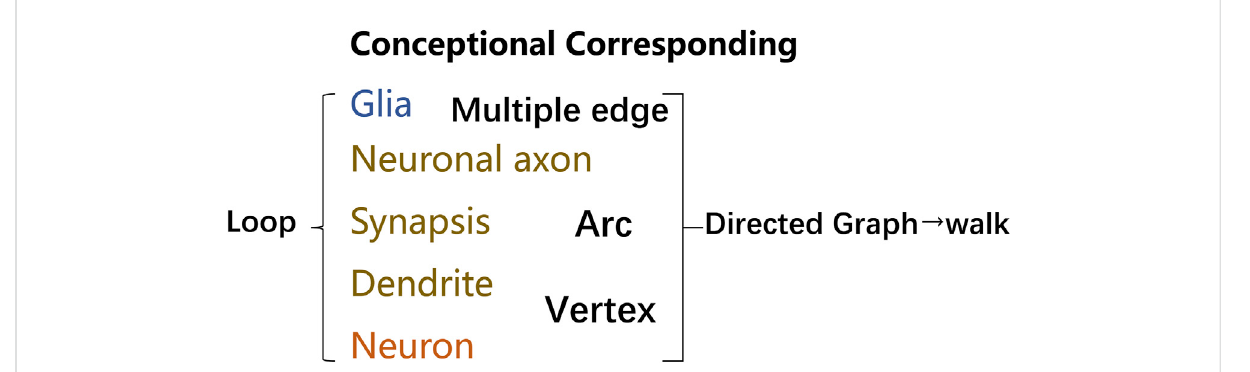
FIGURE 2 Terminology in graph theory corresponding to neural networks. Graphs provide a better way to deal with abstract concepts such as relationships and interactions. Neural loops can be abstracted into graphs utilizing concepts, and graphs made up of vertex and edge may be describedanalyticallyorasmatrices.Glialcellscanberepresentedasnodesoredges,manyofwhichcancorrespondtomultipleedges,whereedges can be directed vectors or arcs. Similarly, dendrites and neurons can be represented as vertex, with edges and nodes labeled with weights that re fl ect varying degrees of information in positive or negative directions. Neuronal axons can be used as arcs to link different related functional regions, and neural loops can be formed between many neuronal structures. A walk is a fi nite sequence that takes the form of a graph ’ s vertices and edges. The walk is open if the beginning and last vertices are different. The walk is a closed loop if the initial and fi nal vertex is the same.